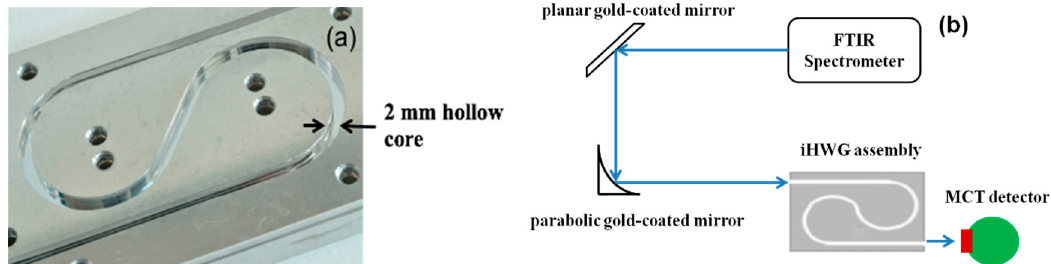
Figure 3. ( a ) Substrate-integrated hollow waveguide (iHWG) assembly with a yin-yang structure; ( b ) Schematic of the iHWG sensor system [62]. (FTIR: Fourier Transform Infrared Spectrometer; MCT: